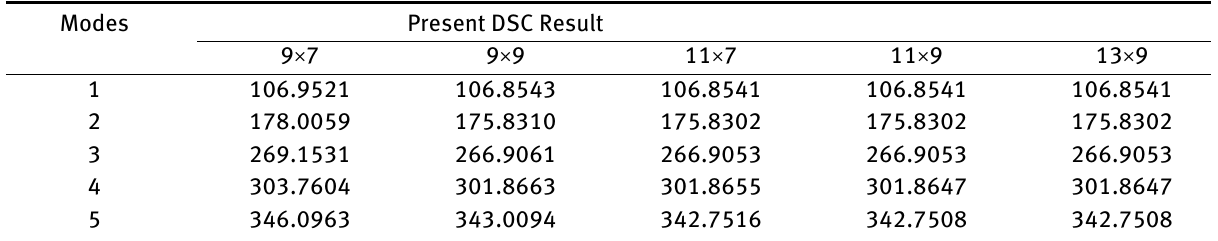
Table 3: Frequencies ( Ω = ωR 2 2 √︀ ρh / D ) of annular sector plates ( υ =0.3; α =45 0 ; R 1 /R 2 =0.5 ) with SCSC edge conditions